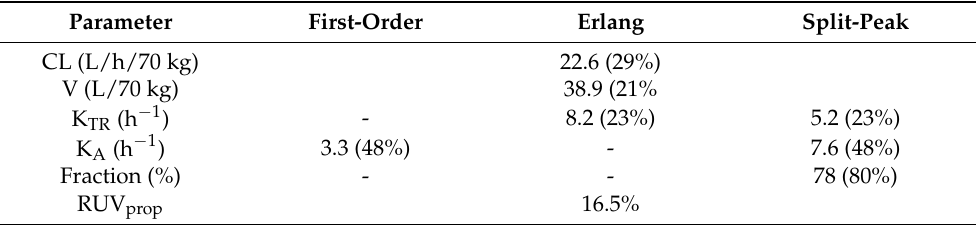
Table 1. Population-level pharmacokinetic estimates and the between-subject variabilities (% CV) from the reanalysis used in the